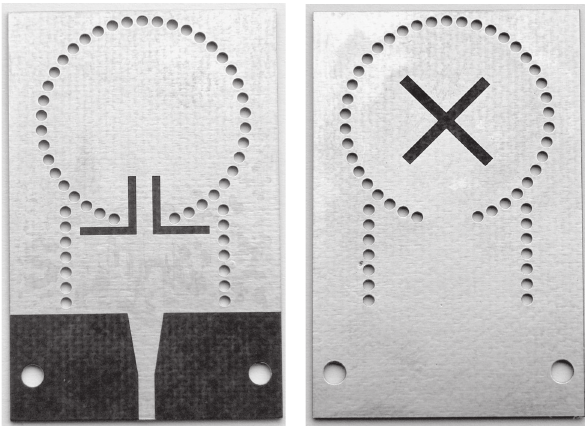
Figure 4: Photographs of the fabricated antenna.